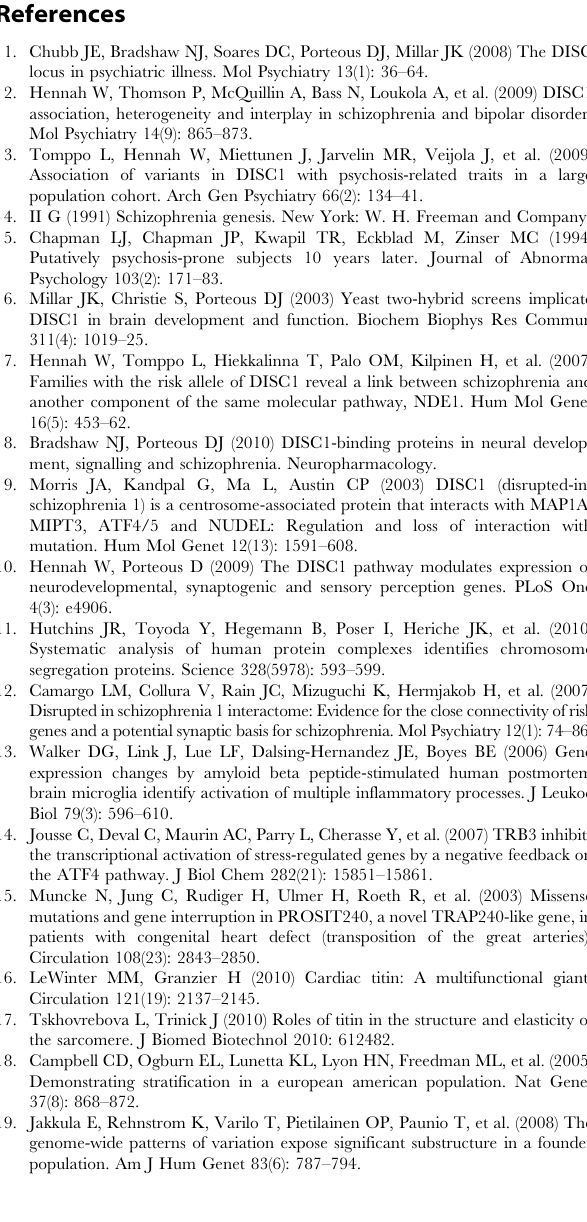
Figure S3 The schematics show the QQ plots for the observed 2 log10 P-values versus those expected by change for Revised Social Anhedonia Scale. (a) and Revised Physical Anhedonia Scale (b) risk (1), protective (2), neutral (3) and covariated (4) models. Table S1 Summary of the SNPs displaying P-valu- es , 10E-4 and located within clusters of three such SNPs. For all the SNPs, the closest gene and the shortest distance to the gene in base pairs are indicated. Table S2 Summary of the SNPs with P , 1E-4 within the loci with biological relevance for schizophrenia and the DISC1 pathway.